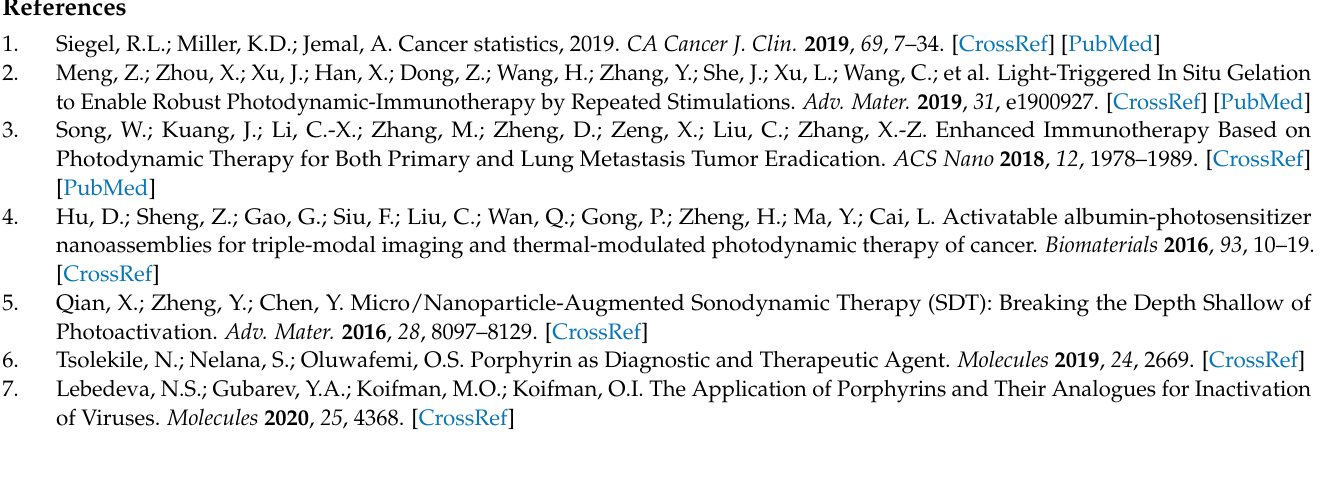
Figure S9: Following the experimental condition of Figure 7: (a) Before ultrasonication (no Hoechst or PI treatment). (b) Cells were treated with Hoechst and PI once after ultrasonication. (c) second cycle of ultrasonication and then overnight. The images of Hoechst-stained cells were collected by exciting with a blue light which was guided through a 370 ± 10 nm bp filter, and the emission wavelength rang was collected through a 450 nm lp filter (A cube). The images of PI-stained cells were excited by a green light which was guided through a 530 ± 20 nm bp filter, and the emission wavelength rang was collected through a 590 nm lp filter (N cube). Under this light intensity condition, the red emission was from PI, not